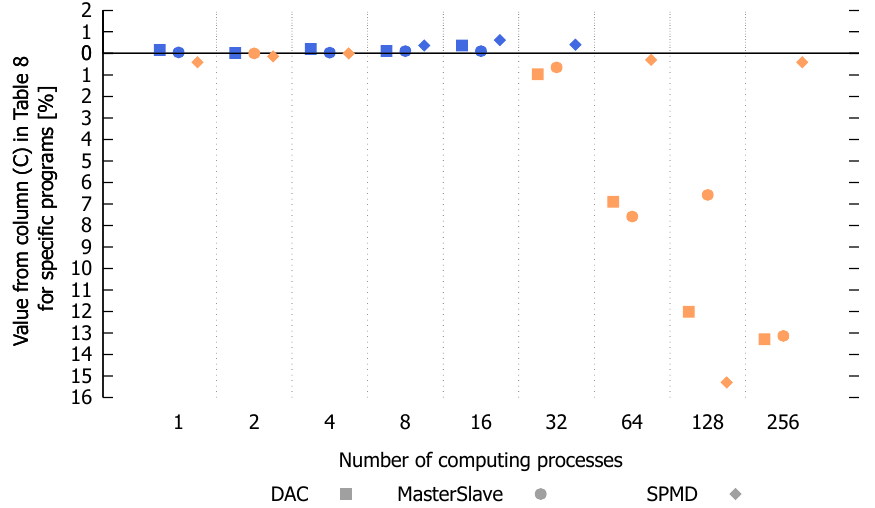
Figure 14. Host and Docker comparison of execution times; orange points denote the overhead of Docker while blue points correspond to minimally better Docker execution times.